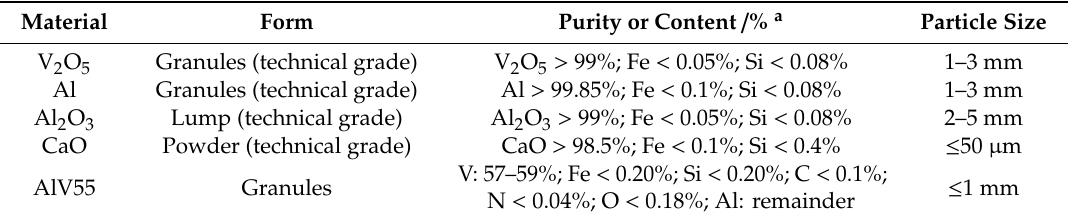
Table 1. The raw materials in the